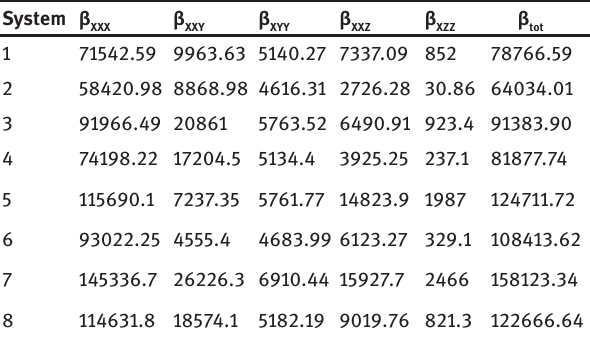
Table 3: Second-order polarizabilities β tensors (a.u).